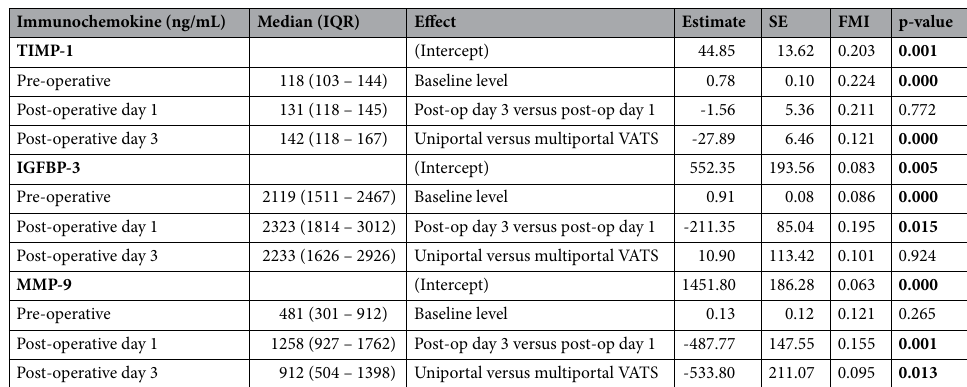
Table 4. Post-operative serum immunochemokine level analysis after Uniportal VATS versus Multiportal VATS. IQR: Interquartile range; Estimate: regression coefficient estimate; SE: standard error; FMI: fraction of missing information; IGFBP-3: Insulin Growth Factor Binding Protein-3; MMP-9: Matrix Metalloproteinase-9; TIMP-1: Tissue Inhibitor of Metalloproteinase-1. Bold signifies significant p -value of